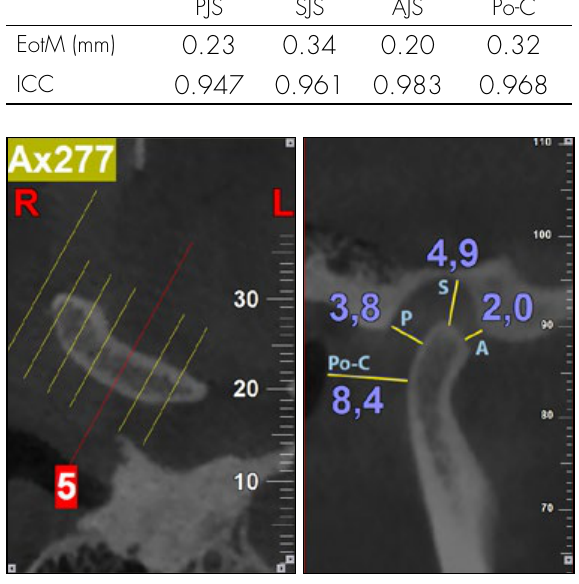
Figure 3. Temporomandibular measurements taken on CBCT cross sectional images of the temporomandibular articulation perpendicular to the condylar axis according to Vitral. 23 The measurements allow access to condylar position within the articular fossa: P- posterior space, S- superior space, A- anterior space, Po-C- the distance between the posterior surface of the condyle and porion.